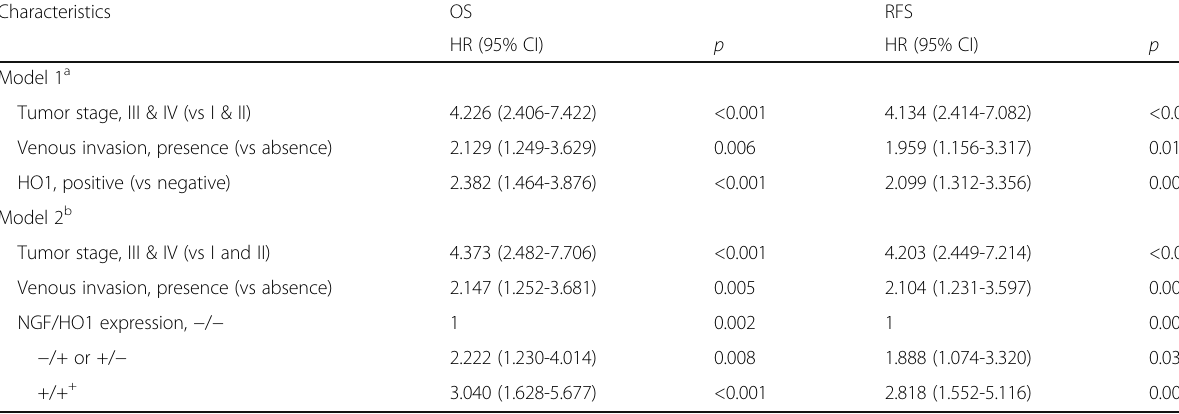
Table 3 Multivariate Cox regression analysis for the survival of gastric carcinoma patients